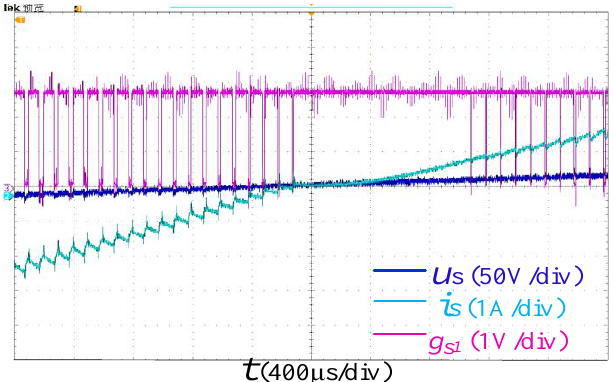
Figure 23. Zoomed-in experiment waveforms of grid voltage and input current under unity power factor.